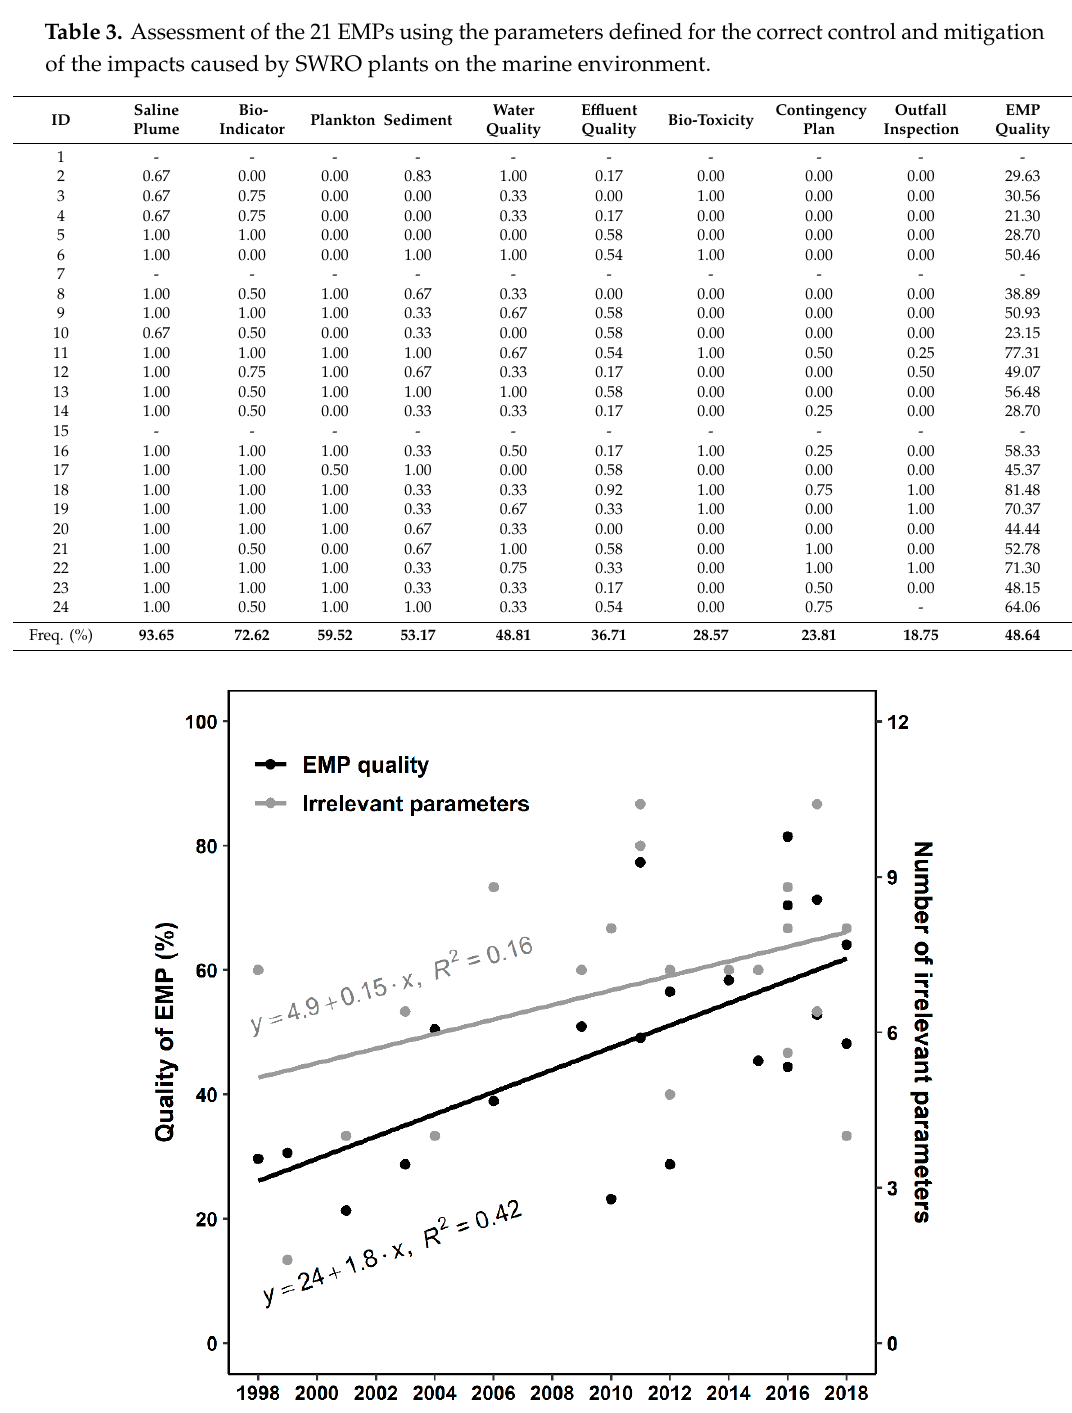
Figure 6. Linear regression between the number of environmental requirements in Chile’s EMPs and the publishing year in the SEIA (black line) as well as the linear regression between the number of irrelevant parameters in EMPs and their publishing year (gray line).